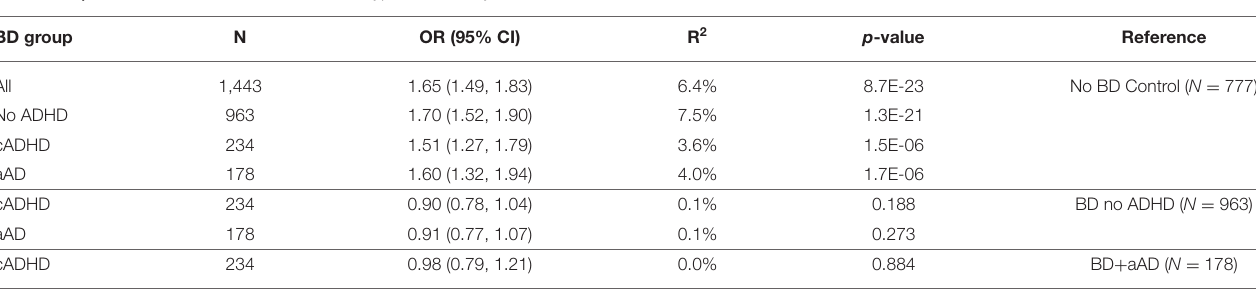
TABLE 2B | Associations of BD PRS with BD subtypes defined by cADHD and aAD. BD group N OR (95% CI) p